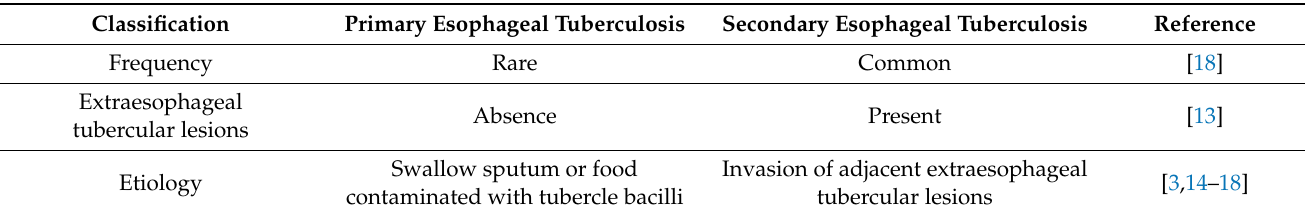
Table 1. Differences between primary and secondary esophageal